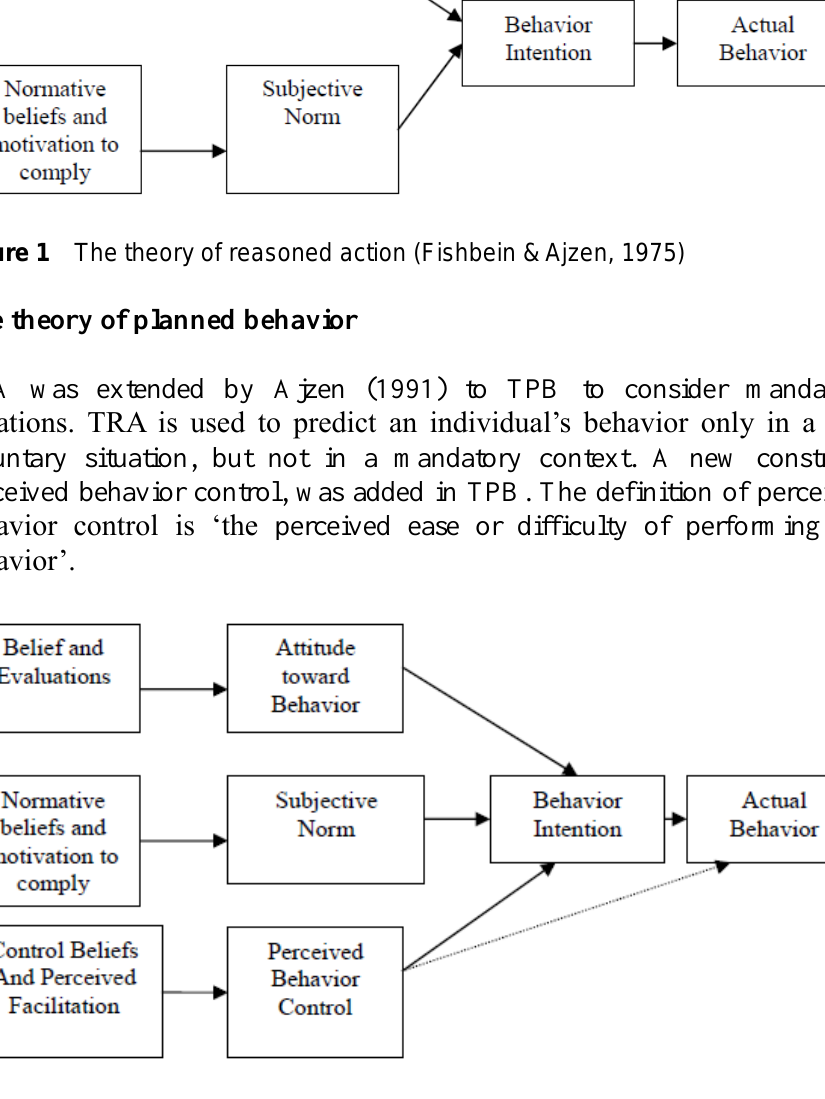
Figure 2 The theory of planned behavior (Ajzen